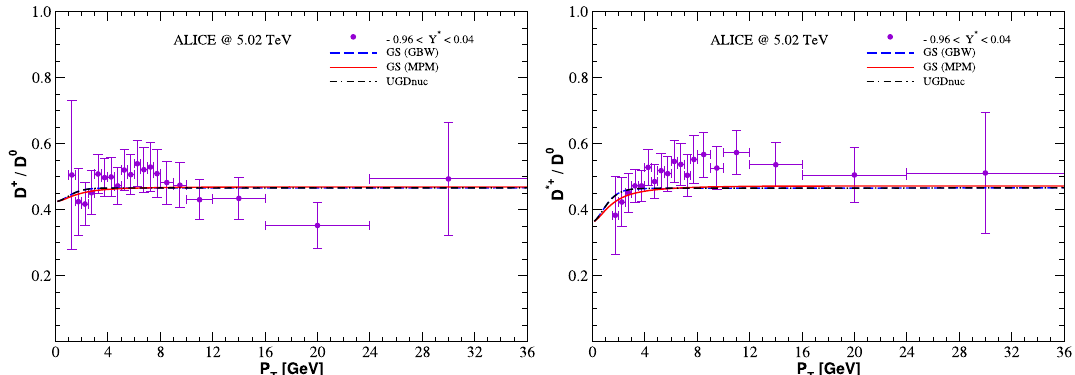
Fig. 5 The ratios as function of P T considering the D + / D 0 (left panel) and D ∗+ / D 0 (right panel) differential production cross sections. The predictions given by the GS (GBW) , GS (MPM) , and UGDnuc models are directly compared to the experimental data from the ALICE Collaboration [73]